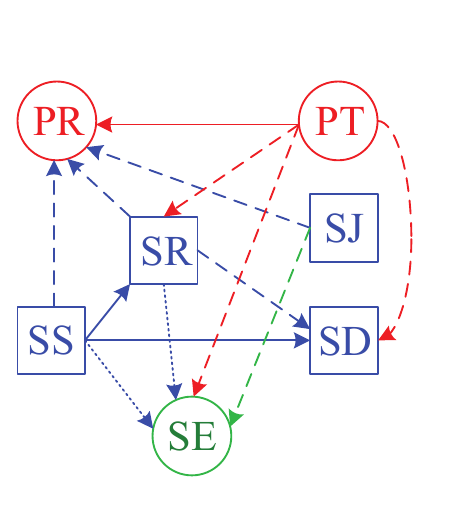
Figure 1. System model of the proposed